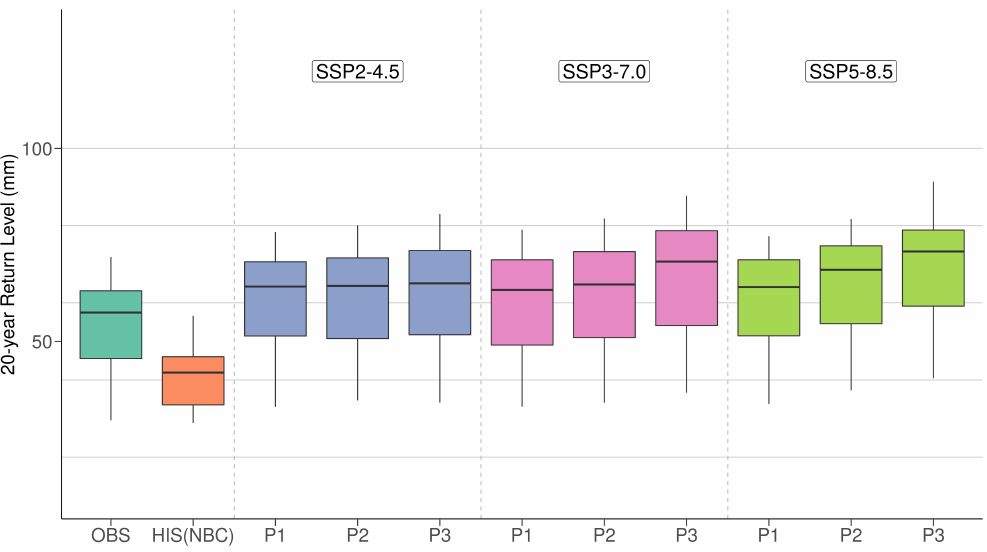
Figure 5. Boxplots of 20-year return levels (unit: mm) of the annual largest daily rainfall averaged over 47 grids in Iran for the future periods, namely P1 (2021–2050), P2 (2046–2075), and P3 (2071–2100), under the SSP2-4.5, SSP3-7.0, and SSP5-8.5 scenarios. OBS and HIST(NBC) stand for the observations and the historical data without a bias correction,